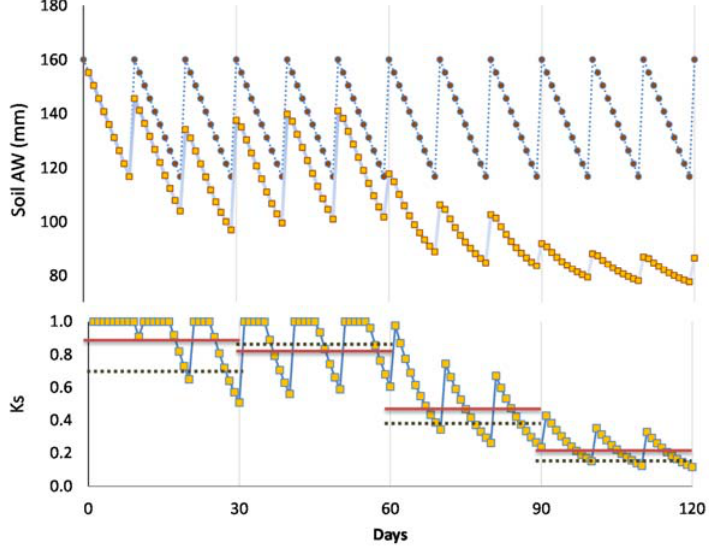
Figure 11. Simulation of ( a ) soil available water and ( b ) Ks (Equation (2)) following decisions on irrigation depths as being at 70%, 90%, 40% and 20% of ETc, in the same days as a fully-irrigated crop, and respectively after Days 0, 30, 60 and 90, assuming p as 0.5, RAW as 44 mm. The dashed horizontal lines indicate the average Ks aimed at during each 30-day period, for comparison with the Ks values actually induced (0.91, 0.88, 0.48 and 0.23, respectively, thin full lines), showing a maladjustment or a delay in the answer that, depending on soil parameters, p and the importance of the changes, can last for several weeks.